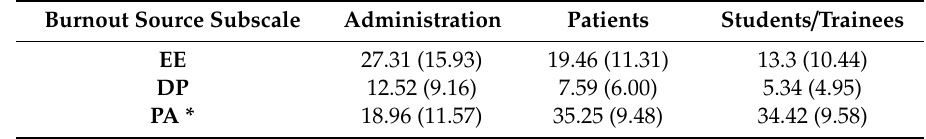
Table 6. Means and standard deviations of the burnout scores for the three types of interactions. Burnout Source